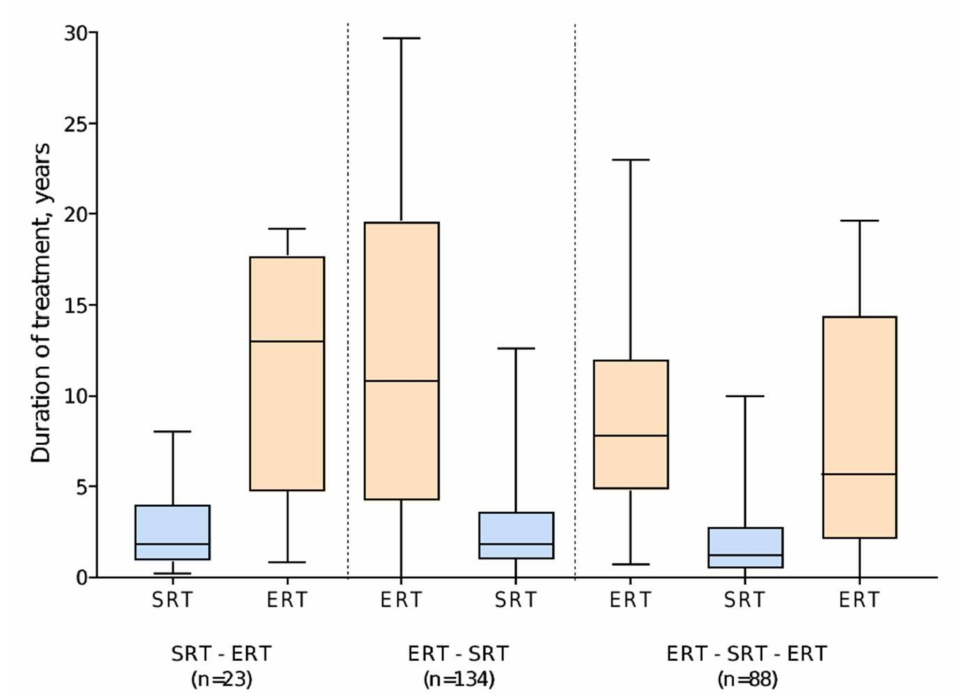
Figure 2. Duration of therapy by treatment